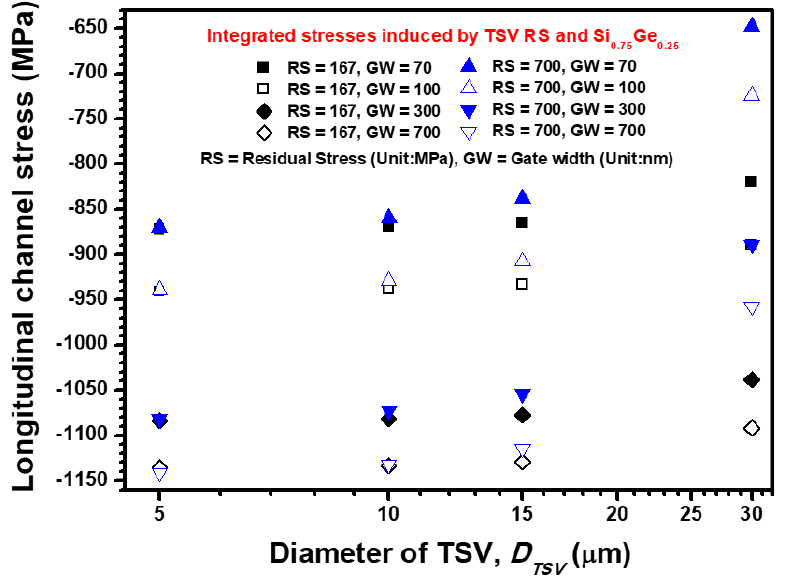
Figure 9. Dependence of the layout and annealing process design on the longitudinal channel stress of Si pMOSFET estimated by the analytical formula, semi-empirical formula and FEA submodeling simulation approach.